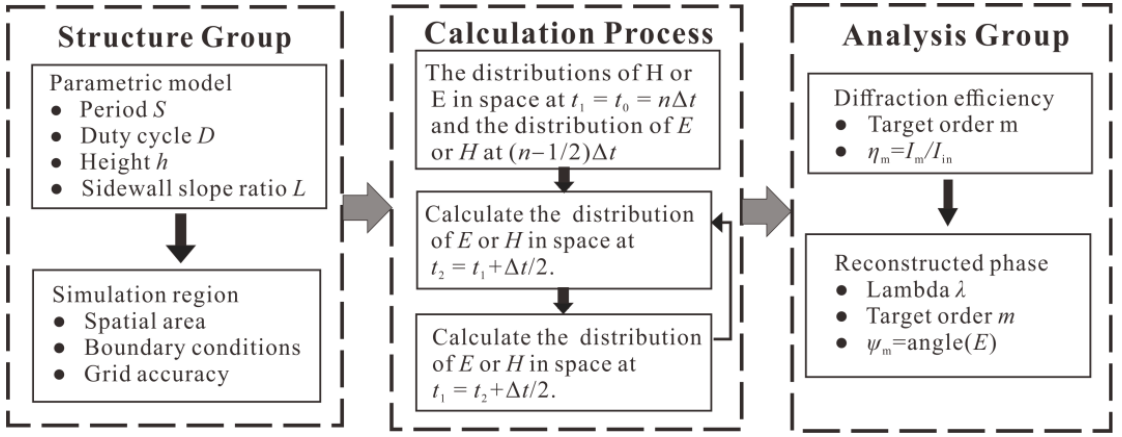
Figure 2. Process of rigorous simulations based on the finite-difference time-domain (FDTD) method. E and H denote the electric and magnetic fields, respectively.